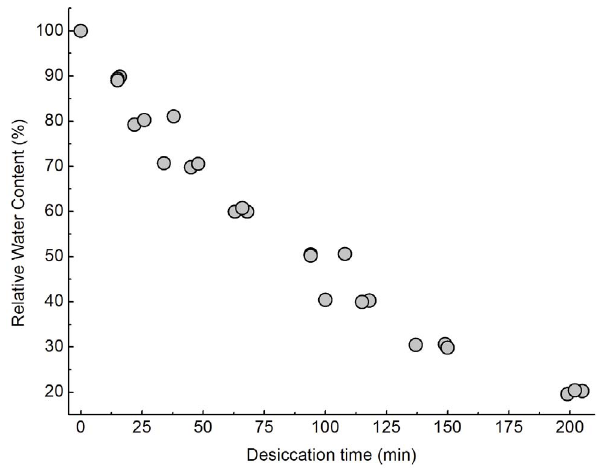
Figure 1. Relative water content in the thalli of U. pertusa desiccated in air. It took about 3.3 hours to dehydrate the thalli to relative water content of 20%. For the calculation of relative water content, see ‘‘Materials and Methods’’. Experiments were performed under dim light at room temperature of about 20 u C.